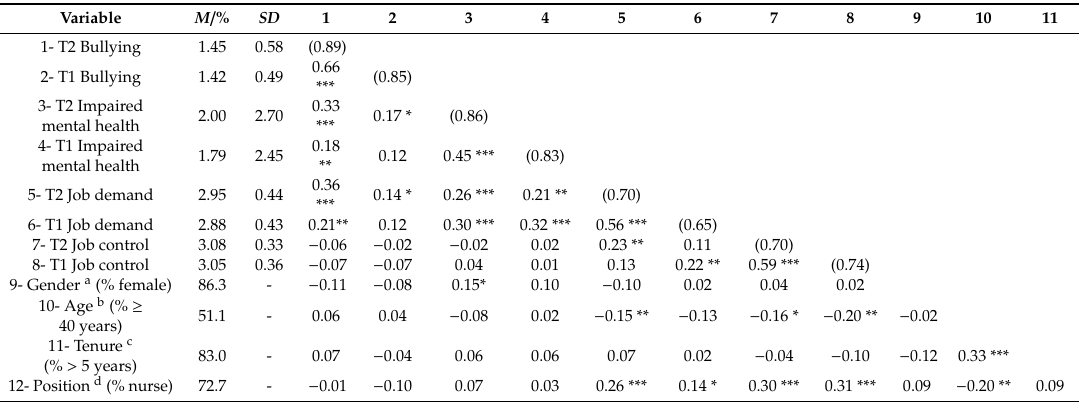
Table 1. Properties and Pearson’s correlations of study variables—Cronbach’s alpha on the diagonal, where appropriate (N varying from 197 to